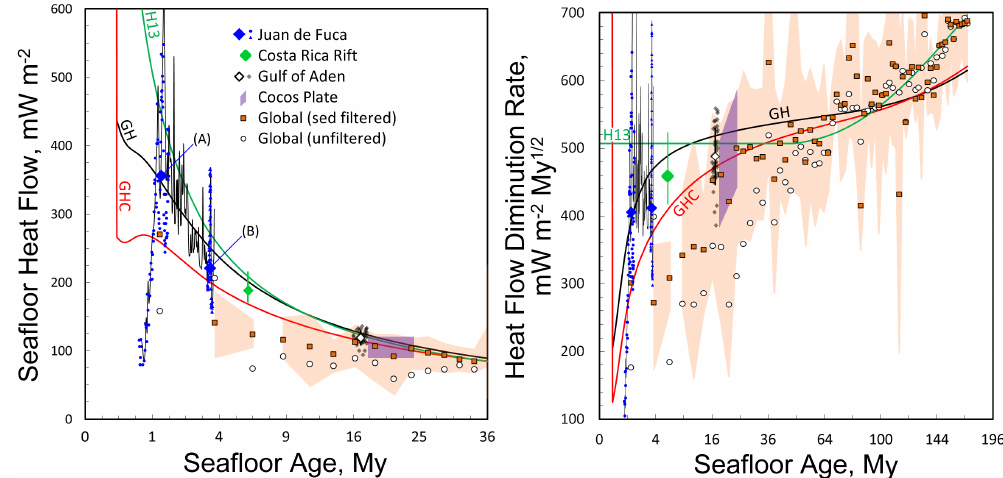
Figure 5. Predicted heat flow (a) and heat flow diminution rate (b) for models H13, GH, and GHC as a function of age compared with global and site-specific data. The site-specific data points are discussed in the text. The global sediment filtered and unfiltered data shown here are from Hasterok (2013b). The highlighted region is the uncertainty (1 σ ) of the sediment-filtered global data set. Note that the misfit between models GHC and the data occurs because Grose and Afonso (2013) fitted model GHC to heat flow data which did not include a correction for continuous